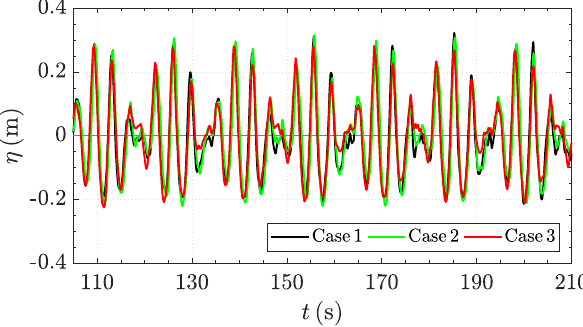
Figure 2. Segment of water surface elevation measurement by RWG at x ≈ −